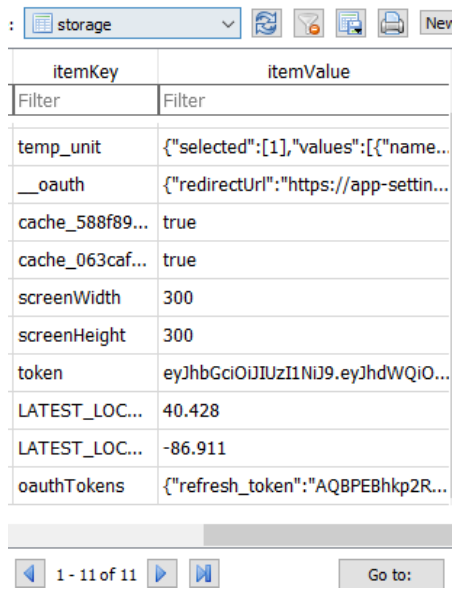
Figure 4. OAuth token data found in plain text using DB Browser for